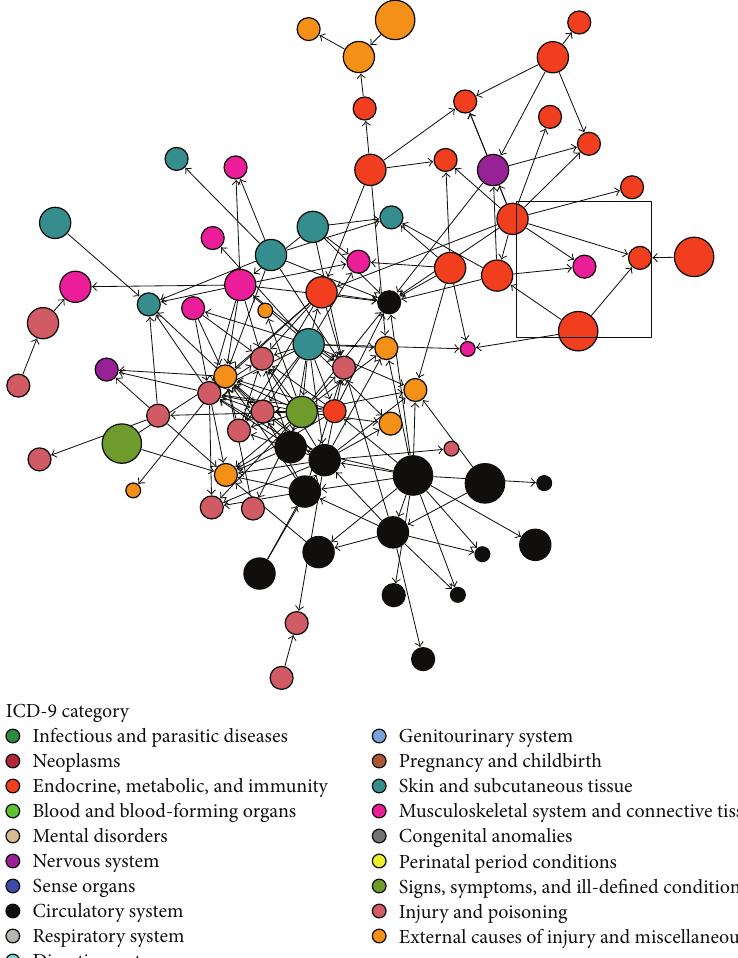
Figure 1: Association diagram showing the clinical milieu in which Charcot foot (pink node in center of square) often exists. Each node represents an ICD-9 code, with the size of the node proportional to its frequency in the overall dataset and node colors representing high-level clinical categories (see legend). Edges between nodes represent highly significant associations. Arrowheads show temporality with preceding nodes pointing to subsequent nodes. This figure was made using the following criteria: association 𝑃 value < 1.0 × 10 −176 ; association odds ratio > 200; temporal 𝑃 value < 1.0 × 10 −6 . The two red nodes directly pointing to Charcot foot are related to type 2 diabetes (ICD-9 codes 250.60 and